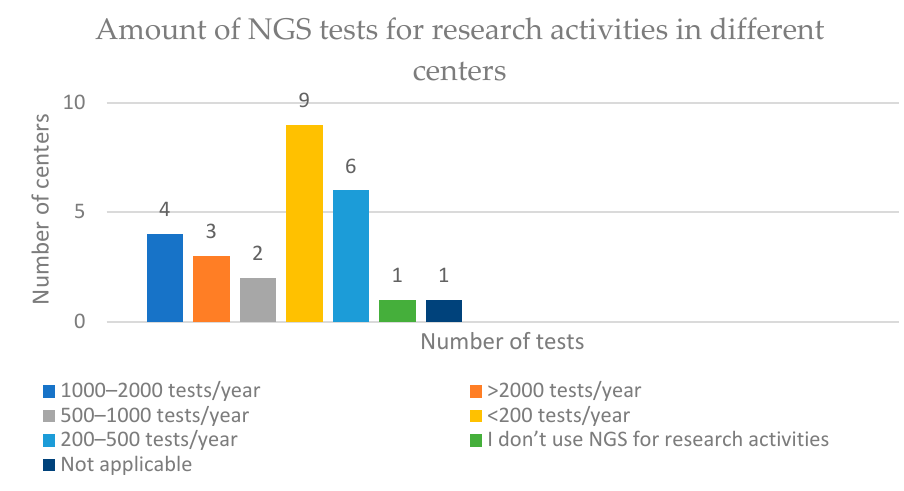
Figure 6. Number of NGS tests used for research activities in different global centres. Table 2. Number of NGS tests used for research and diagnostic activities in different